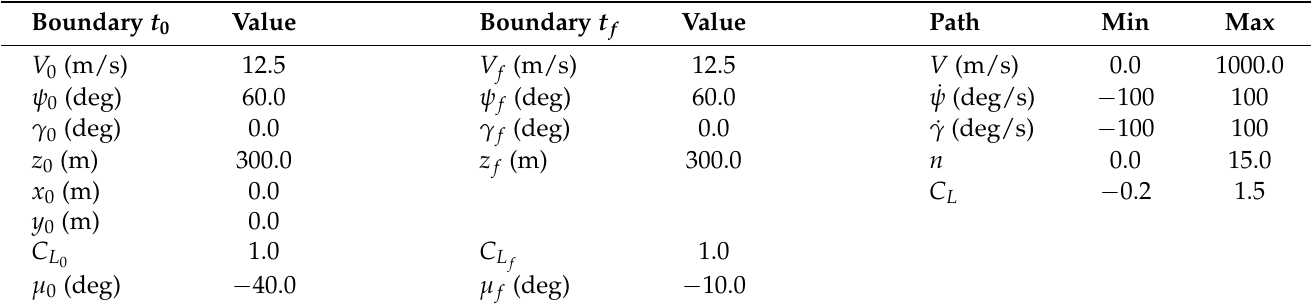
Table 3. Dynamic soaring SUAV trajectory optimization